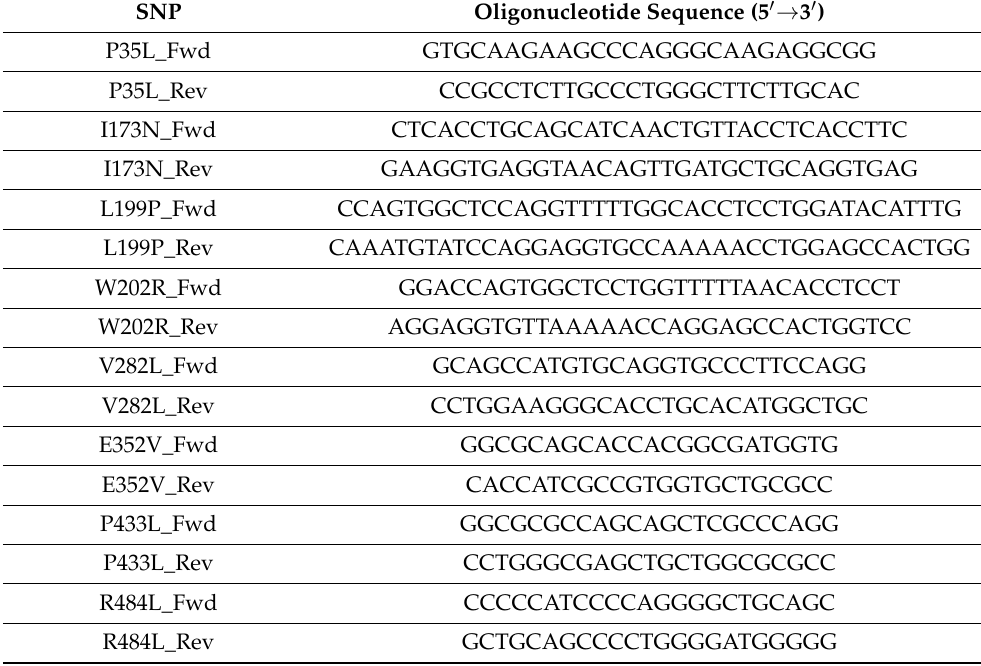
Table 6. Oligonucleotides for site-direct mutagenesis. Fwd–forward, Rev–reverse. SNP Oligonucleotide Sequence (5 (cid:48) → 3 (cid:48)